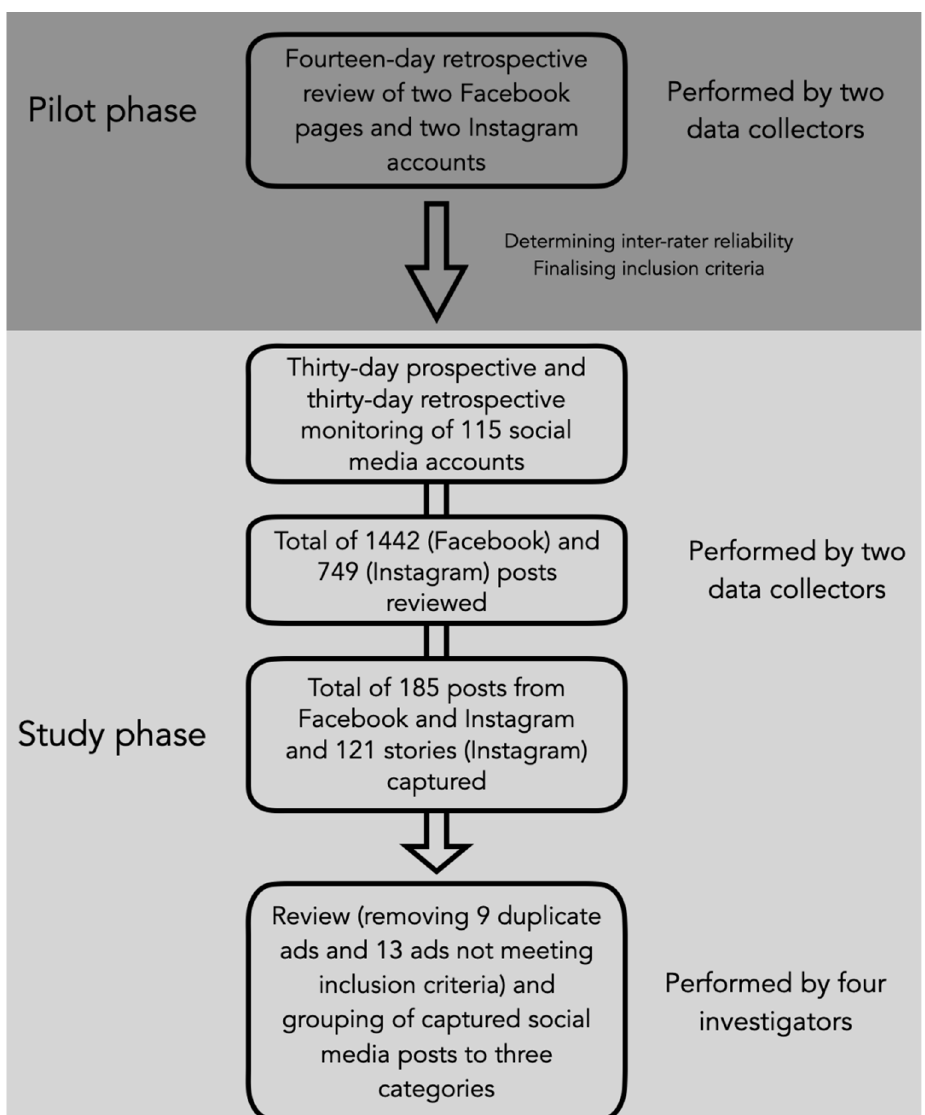
Figure 1. The flowchart of the study design